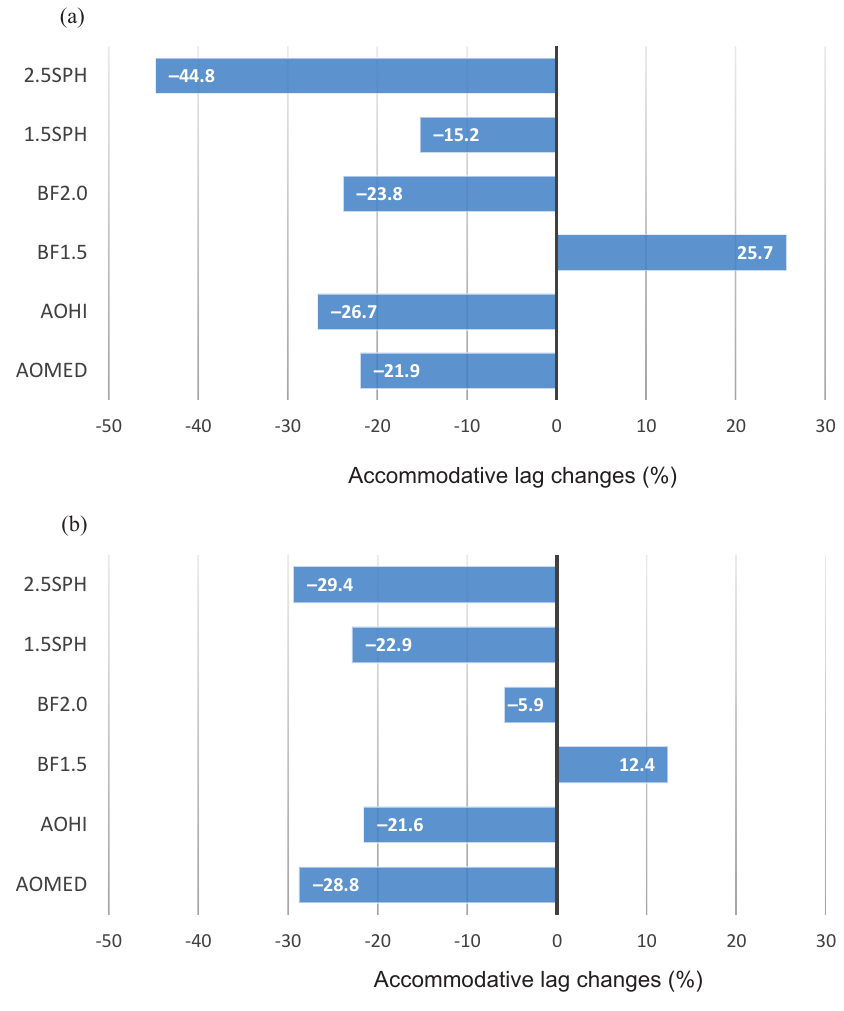
Fig. 1. Accommodative lag changes in percentage (%) for different treatments in contact correction (a) at 40 cm distance and (b) at 25 cm